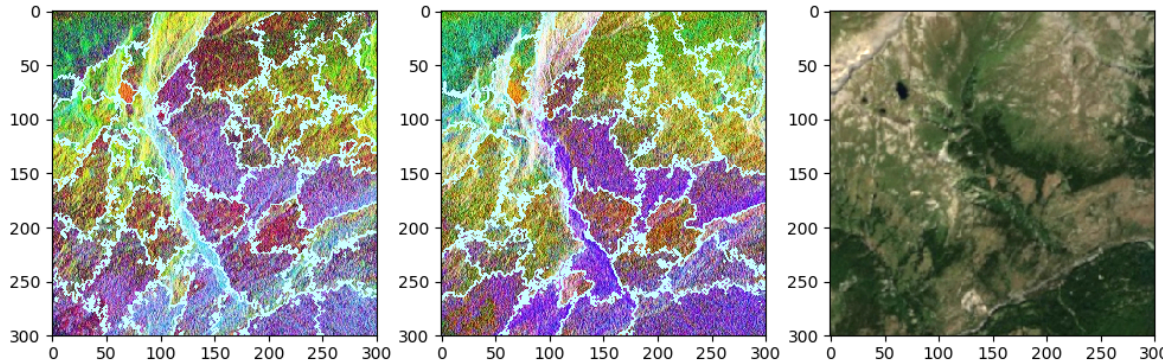
Figure 9. Results obtained by a Quickshift segmentation on the obtained visualizations: CAE on the left, PCA in the middle. The image on the right corresponds to the Sentinel-2 extract on the footprint selected. Three areas leading to different results are